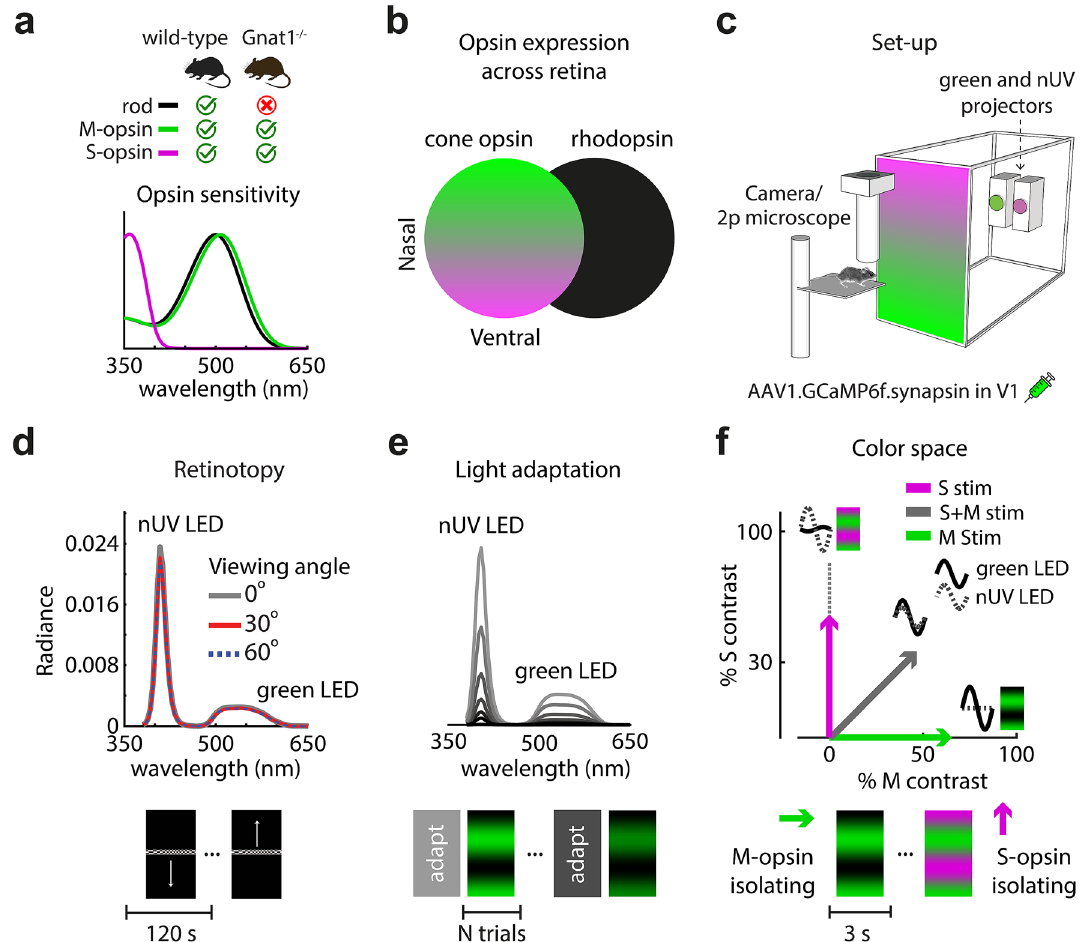
Figure 1. Imaging and visual stimuli setup for mapping retinotopy and color in the mouse V1. ( a ) Opsin sensitivity functions for 3 different types of opsins found in rod and cone photoreceptors. Rhodopsin peaks at 498 nm, while cone S-opsin and M-opsin peak at 360 nm and 508 nm, respectively. 2 mouse genotypes were used: wild-type and Gnat1 −/− , which is a rod-deficient transgenic strain. ( b ) Illustration of cone S/M-opsin expression gradient in mouse retina (left) versus rhodopsin expression (right). Ventral retina (upper visual field) expresses predominantly S-opsin while dorsal retina (lower visual field) expresses predominantly M-opsin. Rods are uniformly expressed throughout retina. ( c ) Rear projection of visual stimuli using two monochromatic projectors, near-UV (nUV) and green. Screen color depicts corresponding S/M-opsin expression in mouse’s retina. ( d ) Measures of the display’s spectral radiance at three viewing angles. Uniformity is required for controlled light adaptation across the retinotopy. Below are the stimuli used to map retinotopy. ( e ) A total of 6 background light levels were used to adapt the retina, with each level scaling the spectral radiance by a factor of 2. Below is an illustration of the adaptation paradigm. Prior to a block of test trials with drifting gratings, the retina was adapted for 10 min by the midpoint (i.e. “gray level”) of the test trials. ( f ) Drifting gratings were calibrated to oscillate along one of three axes in S and M cone-opsin space: S, M, and S + M. The sine-wave insets indicate relative green and nUV LED amplitude and phase used for each of the three color axes. Below is an illustration of a stimulus paradigm for measuring color preference, where each trial showed a different color at a given adaptation